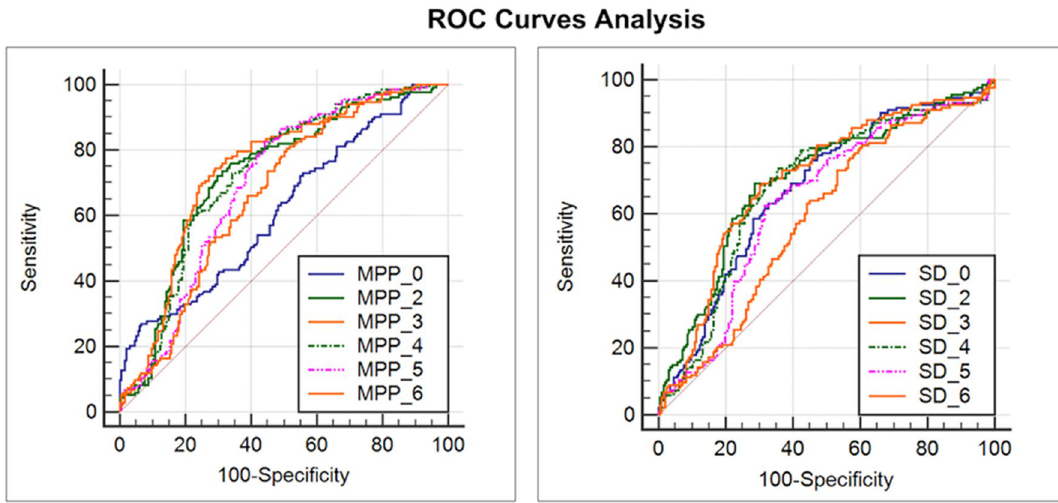
Figure 2. Figure shows the graphical representation of receiving operator curve (ROC) of pretreatment texture parameters with the best area under the curve (AUC), in particular is possible to appreciate standard deviation and MPP parameters as follows: MPP with Spatial Filter Scale (SSF) 2, 3 and 4 showed an AUC of 0.726, 0.743 and 0.726 respectively (all P < 0.001) and a sensitivity of 72.2, 74.4 and 72.9 and specificity of 70.3, 70.8 and 65,6 respectively. Otherwise, both Standard Deviation at SFF 2 and 3 found an AUC of 0.70 (all P < 0.001) with sensitivity of 69.2 for SSF 2 and 3 and specificity of 71.3 and 69.2 respectively.